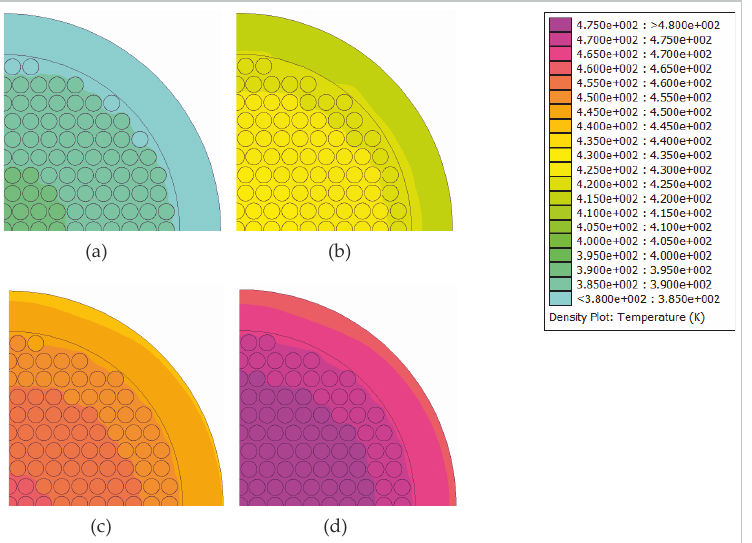
Figure 6. Temperature distribution inside the cable as computed by the coupled FEM routine after 10 min ( a ), 20 min ( b ), 30 min ( c ), and 40 min ( d ). The variations in the average temperature of the strands and insulation as computed by the coupled FEM routine and analytical loss model are compared in Figure 7. In the plots, a third curve is also reported which represents the temperature evolution when only DC losses are considered, i.e., for P = R DC I 2 DC